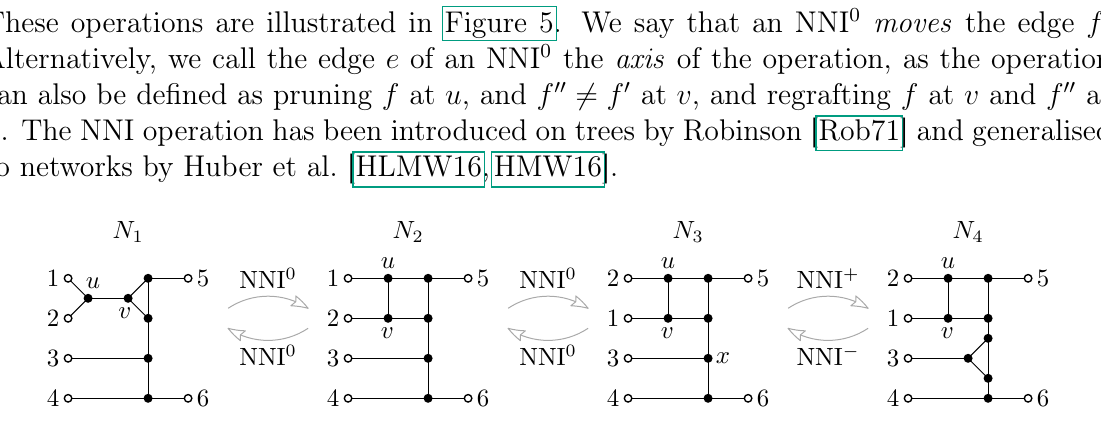
(resp. N ) can be obtained 2 3 can be obtained 2 from N by moving { 1 , u 3 2